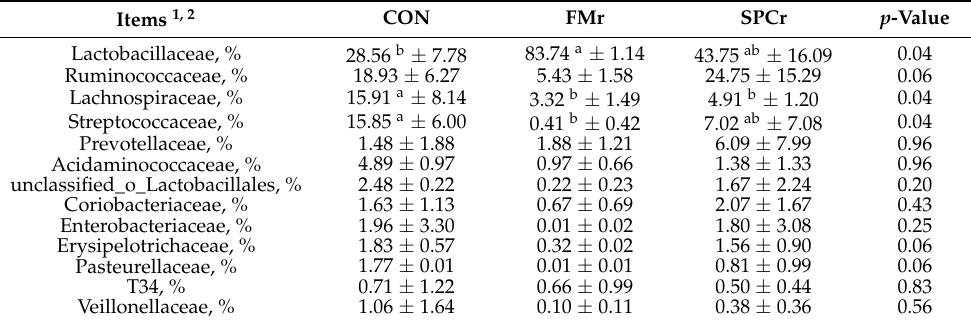
Table 7. Differences in the cecum digesta microbiota composition at family levels.